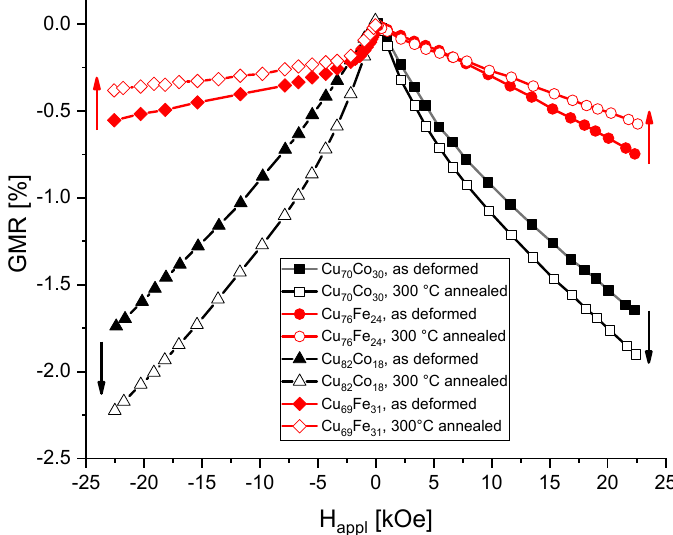
Figure 9. GMR as a function of applied magnetic field for specimens of low ferromagnetic content in the as-deformed state and after annealing for 1 h at 300 °C. Current flow was perpendicular to the applied magnetic field.